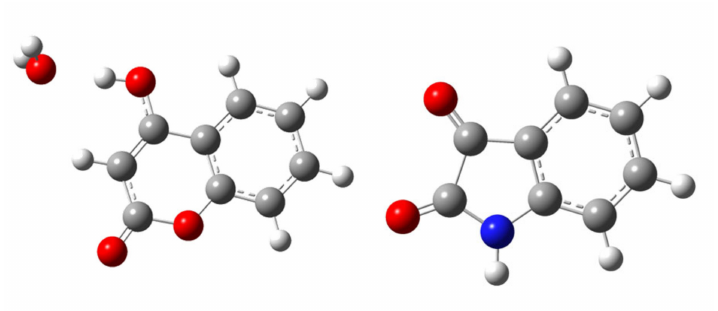
Figure 1. DFT optimized molecular structures of ( left ) CA1 and ( right ) CA4